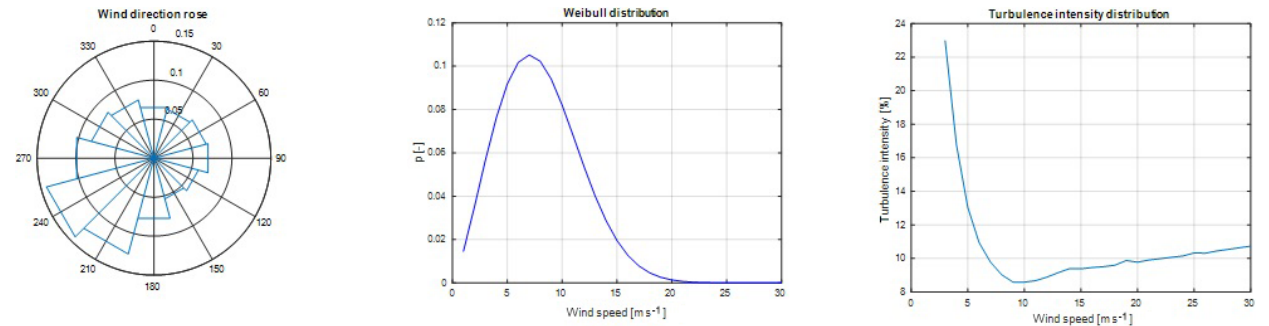
Figure 6. Wind conditions at EWTW: (a) wind rose, (b) Weibull distribution, (c) turbulence intensity as a function of wind speed.